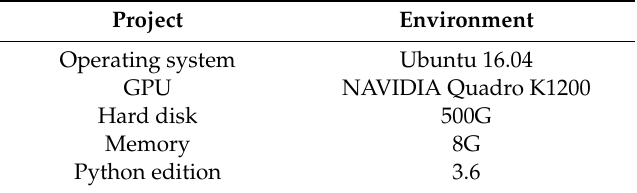
Table 3. Experimental environment.